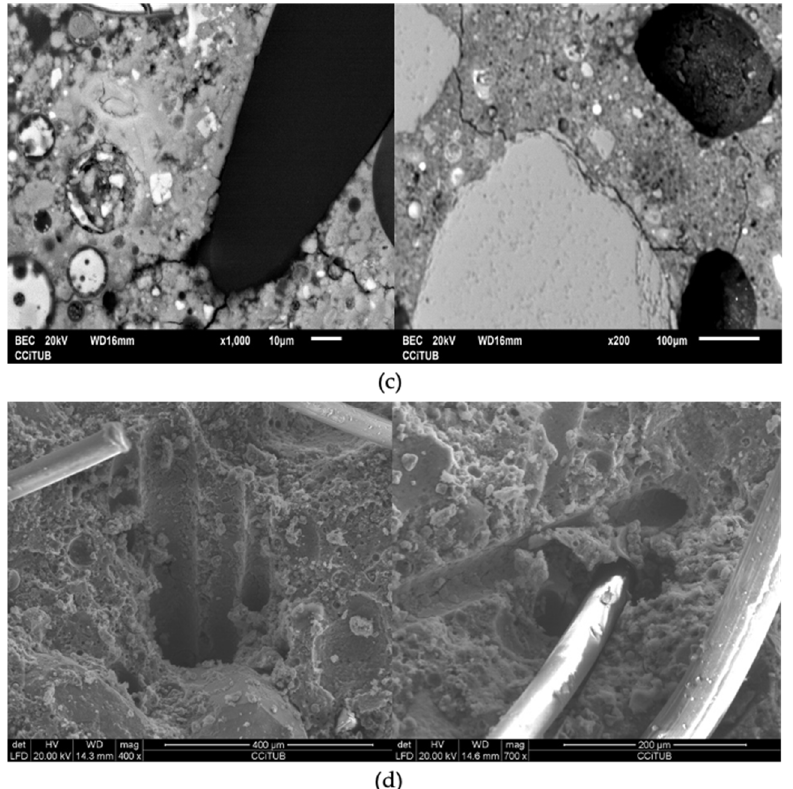
Figure 8. Interaction mechanism between the fibers and geopolymeric matrix; ( a ) Cracking initiation; ( b ) Crack propagation; ( c ) Crack propagation delay; ( d ) Debonding or fiber breakage.